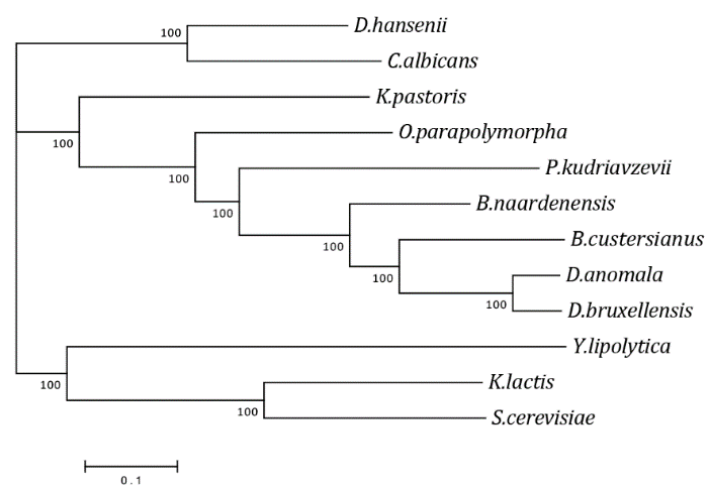
Figure2. Thephylogeneticrelationshipswithinyeastsofthegenus Brettanomyces Figure 2. The phylogenetic relationships within yeasts of the genus Brettanomyces and other yeast species.